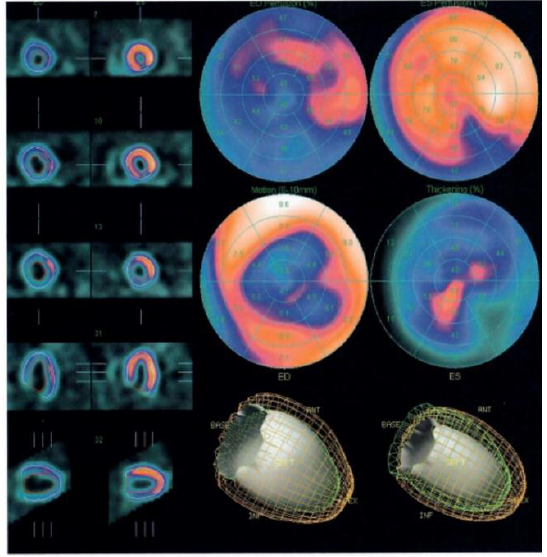
Figure 6. Left ventricular ejection fraction calculated by ECG-gated single photon emission computed tomography. ED = end-diastole; ES = end-systole.